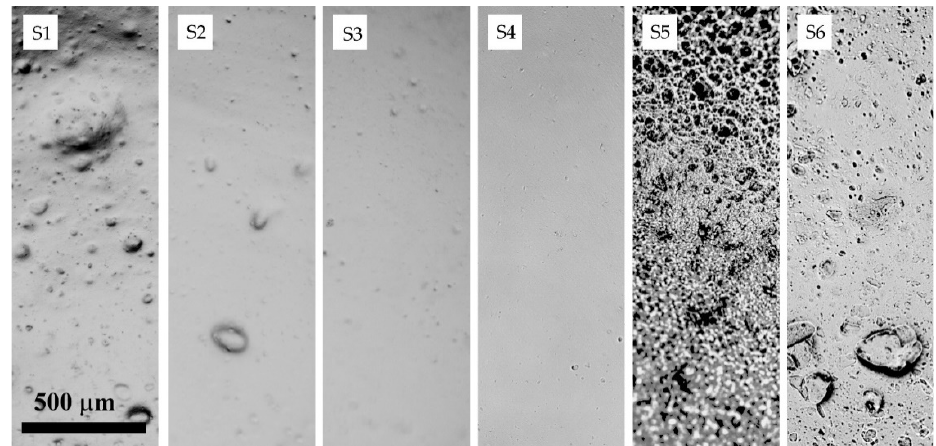
Figure 7. The morphology of the silica-filled PAN films obtained from systems S1 to S6. Images were made by optical microscopy.